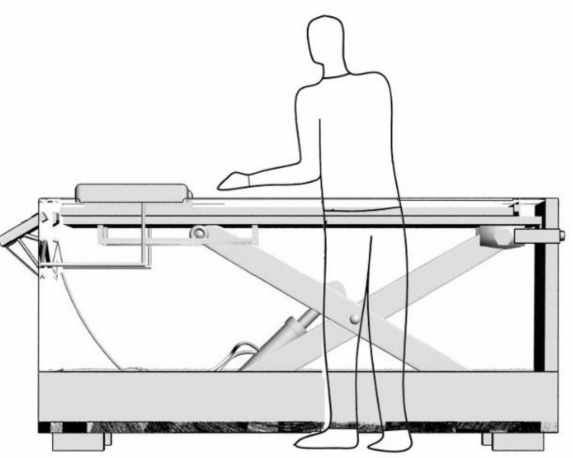
Figure 11. Application of the bend-free boards rack. The uppermost plane of the board pile maintains at the lower end of the elbow, which is set by 5th percentile (96.5 cm for Chinese male). The board is sized no more than 1220 × 610 mm 2 and the number of 18 mm boards is no more than 50